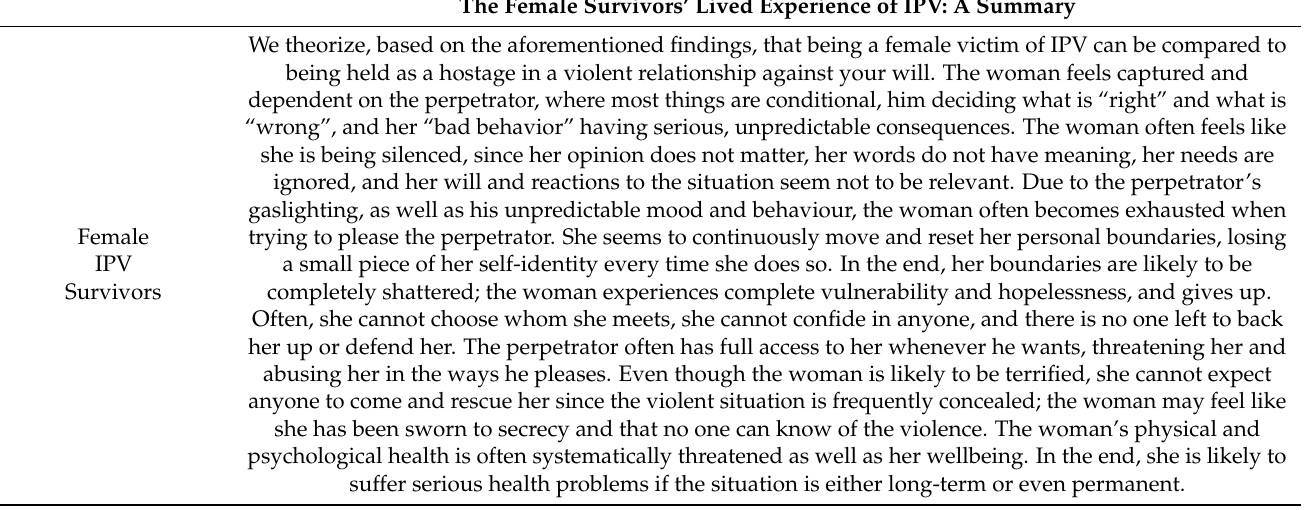
Table 6. Component 3: Overview of experiencing IPV.